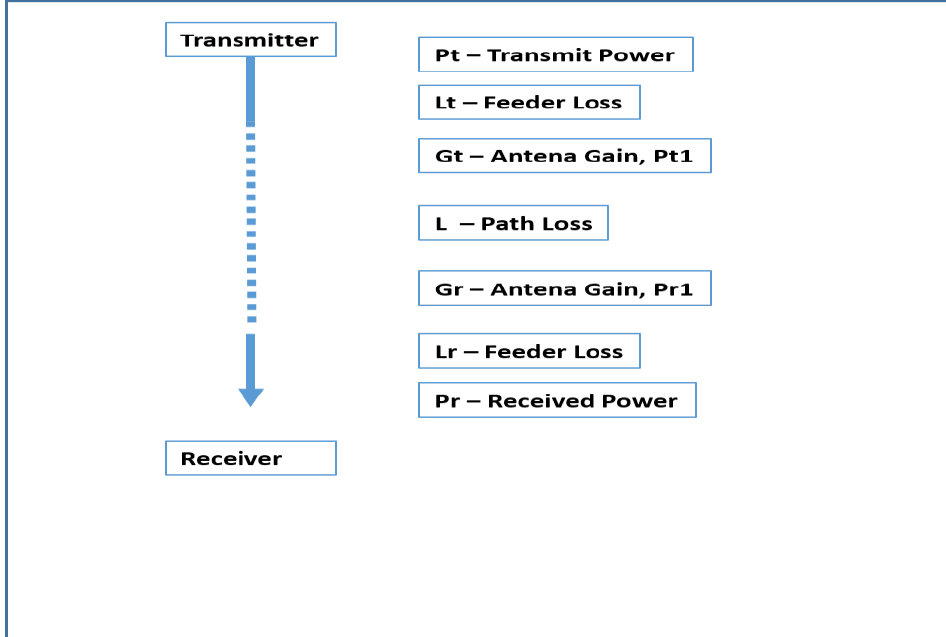
Figure 2. The components used for calculating the LB value.